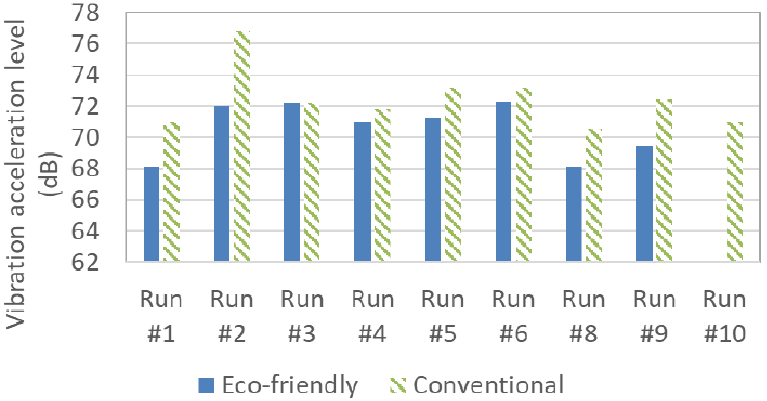
Figure 19. Vibration acceleration level on the slab floor based on the 1/3 octave band analysis.